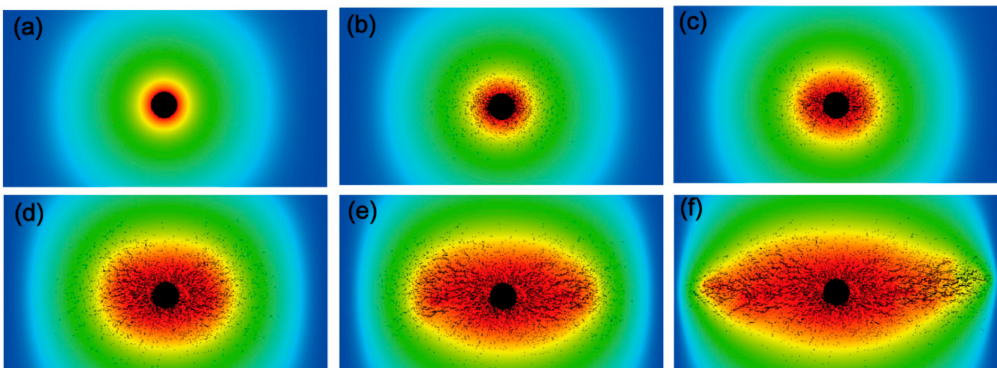
Figure 3. Stages of hydraulic fracturing in heterogeneous rock without weakness planes with increasing pore pressure shown by changes in the color; the location of the fractures is shown by the black lines. ( a ) Initial state; ( b ) Stress accumulation; ( c ) Small fracture formation; ( d ) Hydraulic fracture initiation; ( e ) Hydraulic fracture propagation; ( f ) Decay in fracture